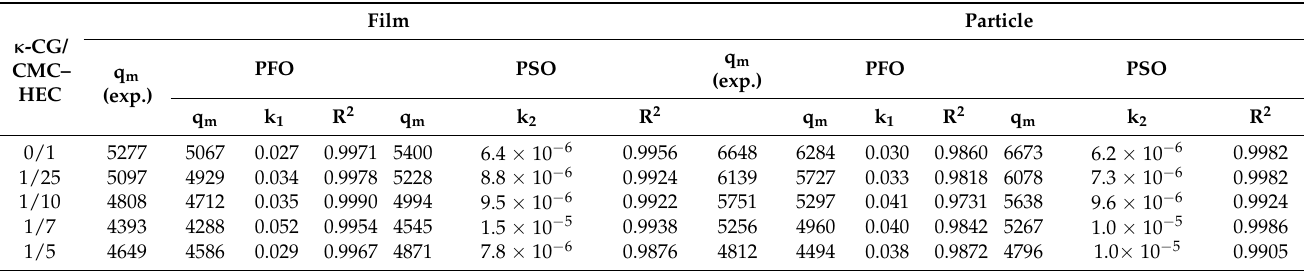
Table 3. Kinetic-model parameters obtained using the nonlinear PFO and PSO models for the water absorption onto the dried gels in deionized water (pH 7) at 25 ◦